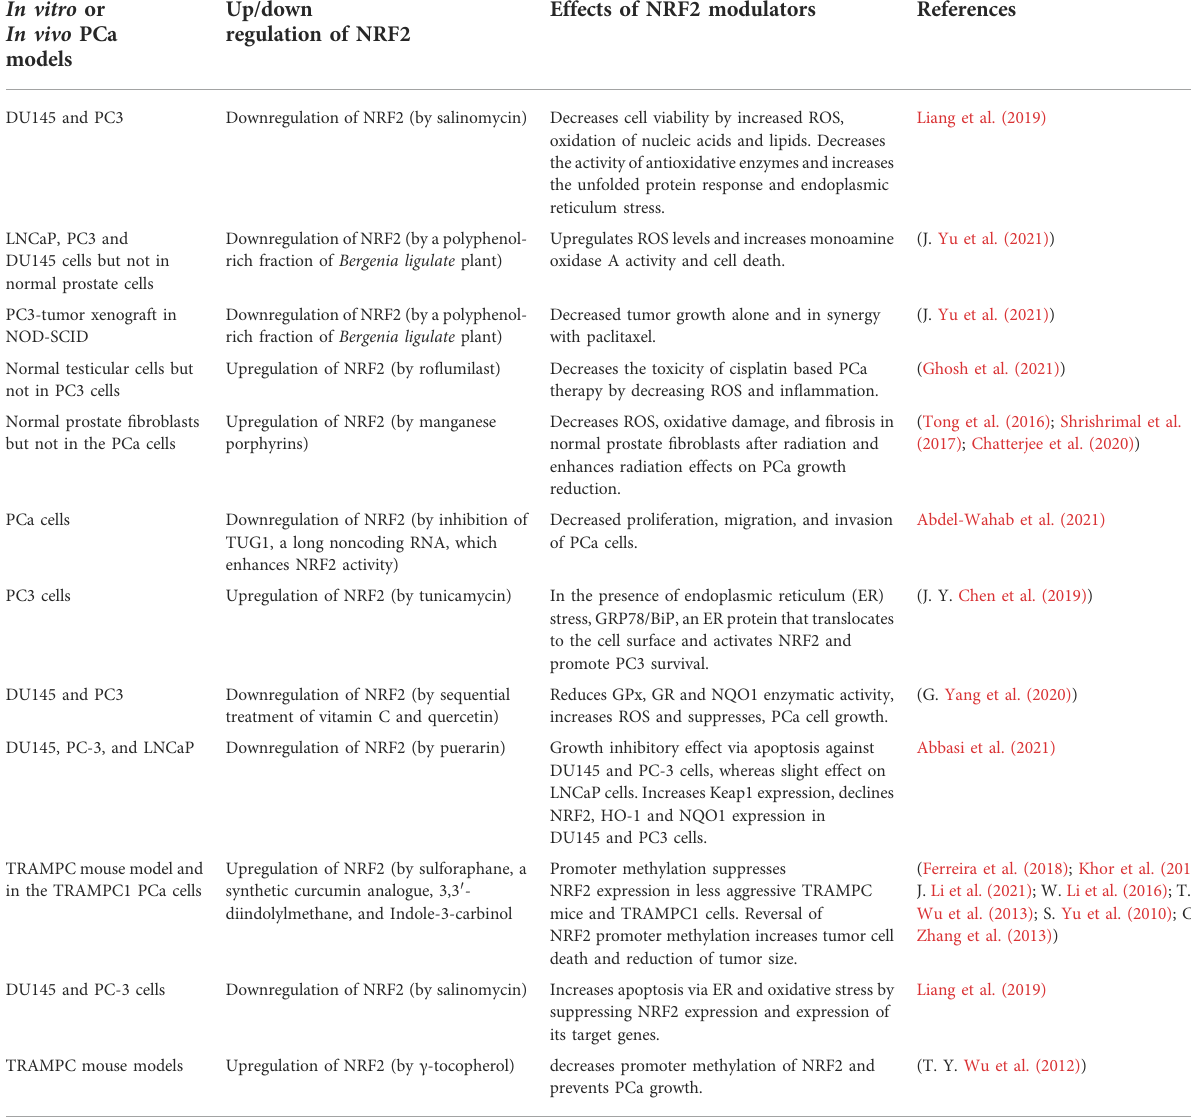
TABLE 1 Effects of NRF2 modulators used in pre-clinical research in PCa growth regulation. In vitro or In vivo